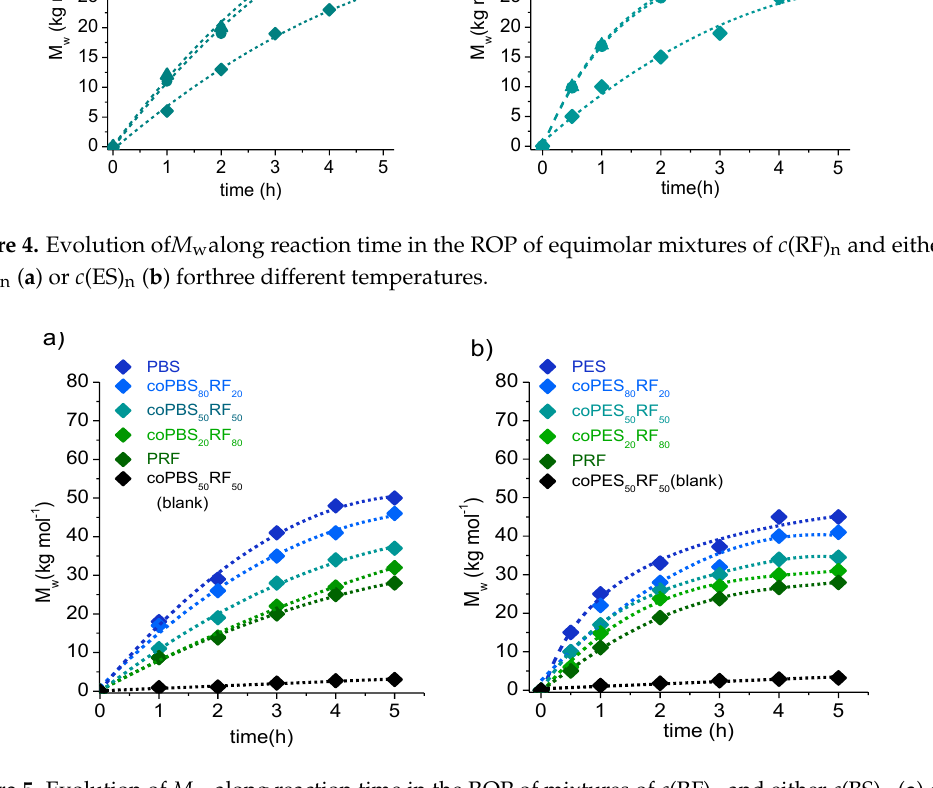
Figure 5. Evolution of M w along reaction time in the ROP of mixtures of c (RF) n and either c (BS) n ( a ) or c (ES) n ( b ) for different feed compositions. Table 2. Resorcinol-containing Succinate-FuranoateCopolyesters Obtained by ROP.